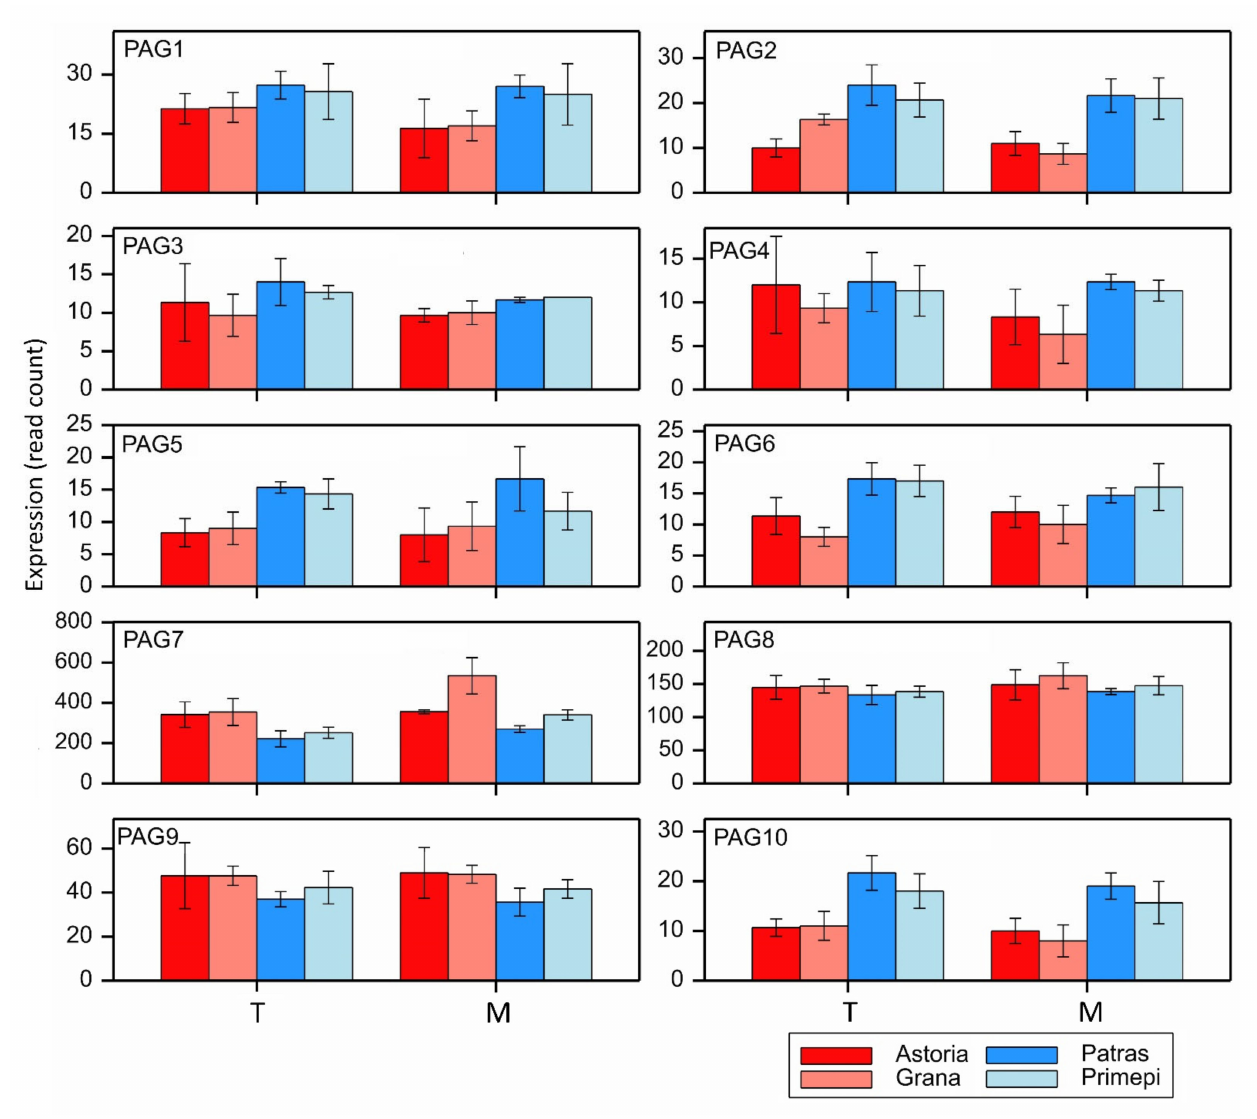
Figure 4. Expression patterns of 10 PAGs in cluster M8. Data are presented as the mean values of the NGS-read counts over the replicates, with error bars corresponding to the standard error of the